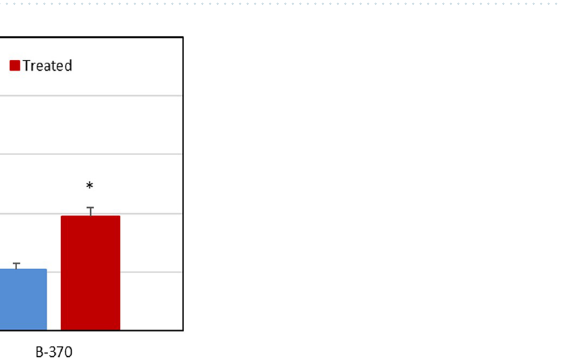
Figure 6. Quantification of 2AP in mature grains of aromatic rice cultivars under salt